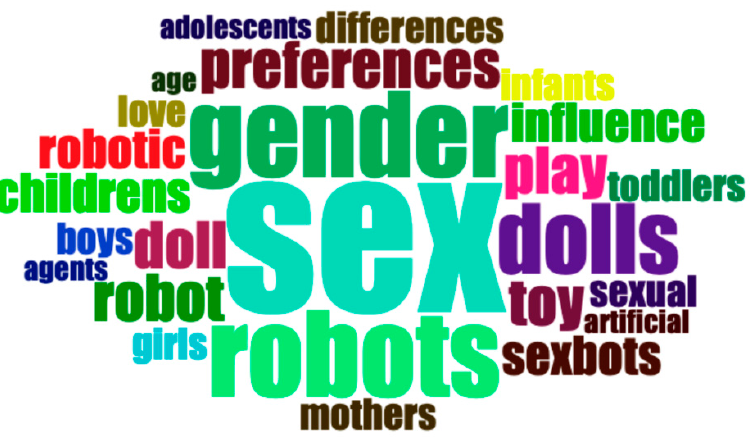
Figure 7. CloudWords with titles of papers found in the review.